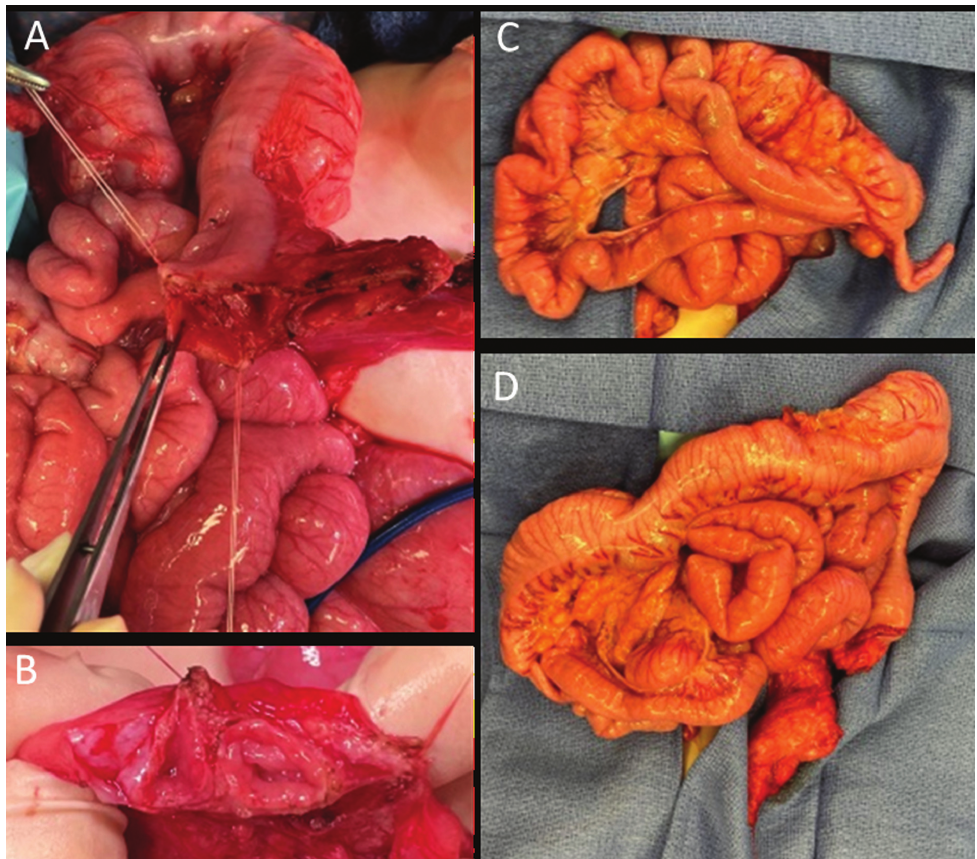
Fig. 4 Intraoperative fi ndings. Three colonic lumens of colostomy ( A ). Two colonic lumens of mucus fi stula ( B ). Ileal, cecal, and appendiceal duplication ( C ). Entire colon with normal outer appearance despite multiple internal lumens ( D